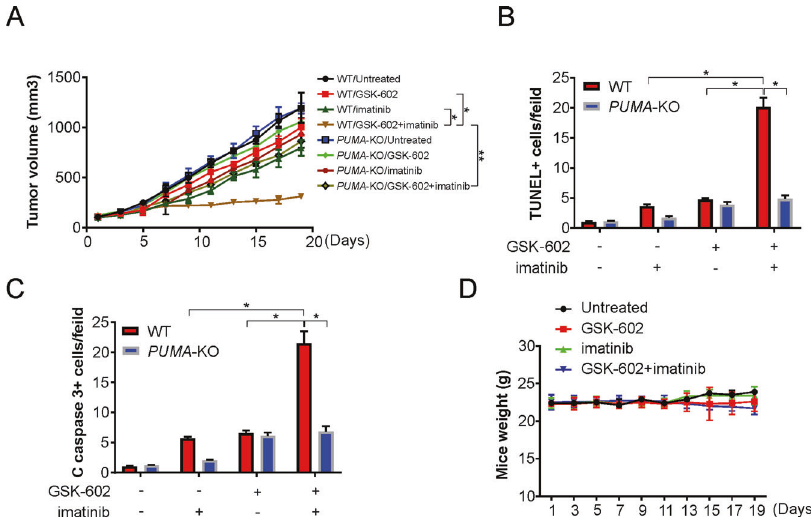
Fig. 6 GSK602 enhances the antitumor effect of imatinib in vivo. A Nude mice were injected s.c. with 5 × 10 6 WT or PUMA -KO GIST-882 cells. After 7 days, mice were treated with 2 mg/kg GSK602 daily, 50 mg/kg imatinib, or their combination for 10 consecutive days. Tumor volume at indicated time points after treatment was calculated and plotted with p values for indicated comparisons, n = 6 in each group. B Mice weight after treatment. C Mice with WT or PUMA -KO GIST-882 xenograft tumors were treated with 2 mg/kg GSK602, 50 mg/kg imatinib, or their combination as in ( A ) for 4 consecutive days. Paraf fi n-embedded sections were analyzed by TUNEL staining. TUNEL-positive cells were counted and plotted. D Tissue sections from ( C ) were analyzed by cleaved caspase 3 staining. Cleaved caspase 3-positive cells were counted and plotted. Results were expressed as means ± SD of three independent experiments. * P < 0.05; ** P < associated malignancy. BRD9 inhibition sensitized GISTs to imatinib by cotargeting the AKT/GSK-3 β /NF- κ B axis, leading to PUMA induction. PUMA is required for the antitumor effects of the combination. Thus, targeting BRD9 can be a novel therapeutic approach with better clinical outcomes in the form of reduced progression and increased life expectancy in GIST patients. DATA AVAILABILITY All data generated or analyzed during this study are included in this published article and its supplementary information fi les.